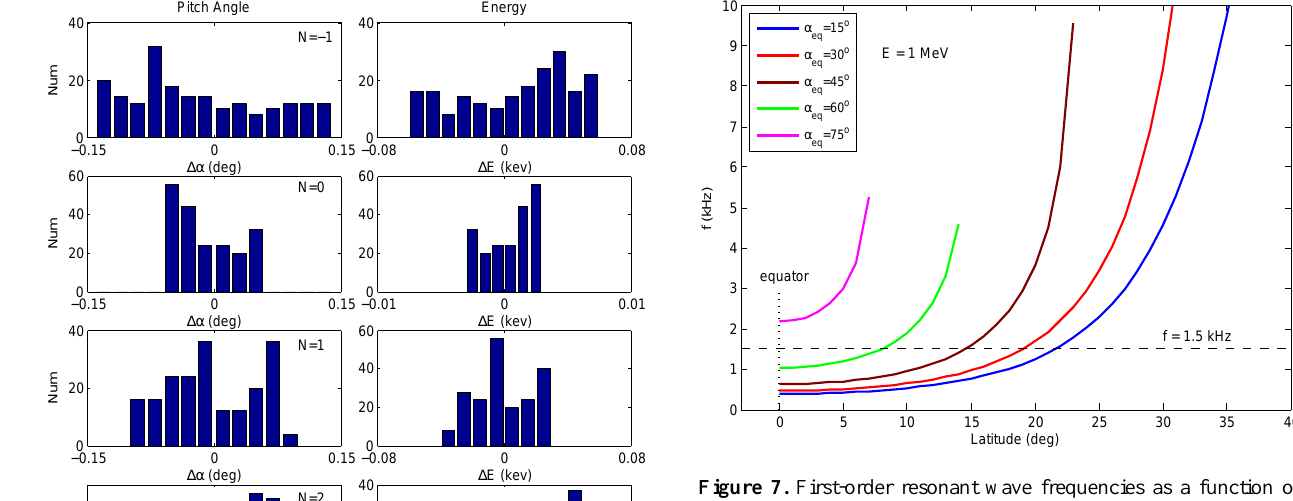
Figure 7. First-order resonant wave frequencies as a function of latitude along the bounce orbit of 1MeV electron at L = 3, for the five indicated equatorial pitch angle (i.e., 15 ◦ , 30 ◦ , 45 ◦ , 60 ◦ , 75 ◦ ). Here, the vertical dotted line shows the resonant wave frequencies for the five indicated equatorial pitch angle at the equator, while the horizontal dashed line shows the resonant latitude for the five indicated equatorial pitch angle when frequency is fixed as